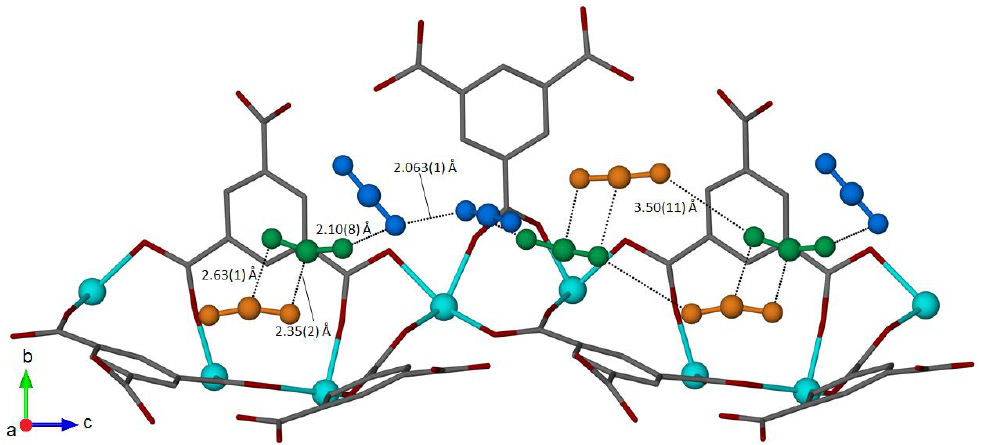
Figure 4. Intermolecular interactions of CO 2 molecules at a dose of 1 CO 2 :Y, as viewed along the a axis. Shown are CO 2 adsorption-site A CO2 (green), site B CO2 (orange) and site C CO2 (blue), and framework atoms Y (light blue), C (dark grey), and O (red). Framework H atoms are omitted for clarity.